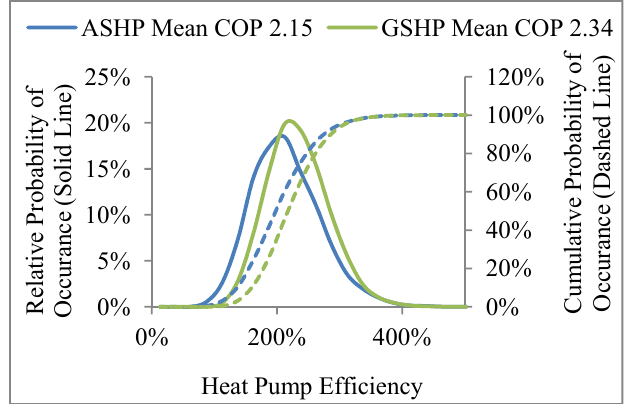
Figure 2. Heat pumps Monte Carlo (MC) performance input distribution.